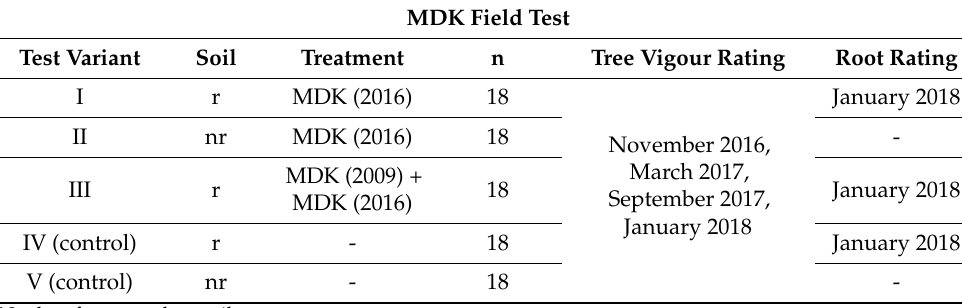
Table 3. MDK Field Test (November 2016 to January 2018) ( n =